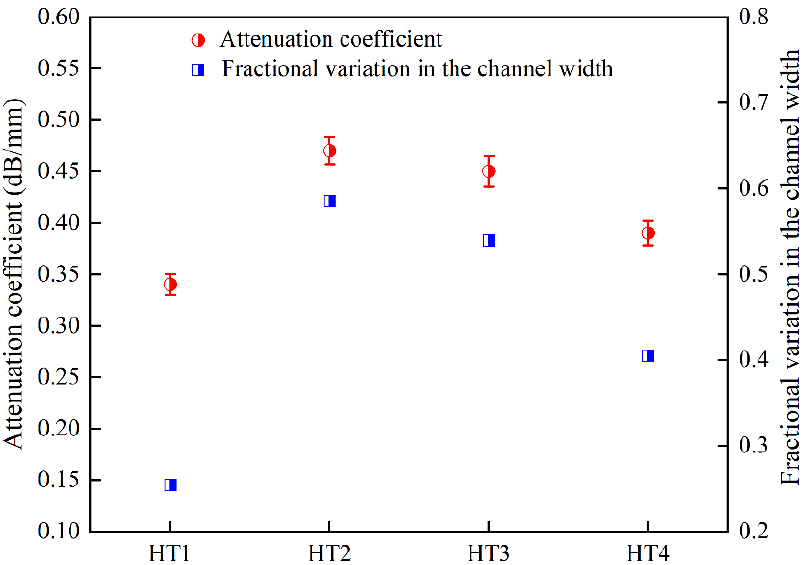
Figure 4. The variation trends in ultrasonic attenuation coefficient and fractional change in the γ channel width under various aging treatment conditions.